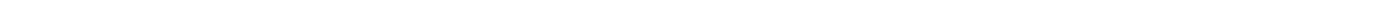
Figure 3 | Gene-deletion mutants Pb D mahrp1a and Pb D sbp1 show reduced schizont sequestration and virulence. ( a ) Survival of C57B/6 mice infected with mutant and wt parasites ( n ¼ 9 mice per group, P o 0.001, logrank test from Kaplan–Meier survival curve). ( b ) The course of parasitemia (mean ± s.d.) in C57B/6 mice ( n ¼ 15 mice per group) infected with 10 5 mutant or wt parasites. Significant differences in parasitemia between wt and both mutants at day 3, 6, 7 ( P o 0.001) and day 5 ( P ¼ 0.005) (two-tailed unpaired t -test). ( c ) Significant increase in number of mutant schizonts in the peripheral blood circulation compared with wt. Schizonts were quantified in Giemsa-stained smears of tail blood obtained 22h after establishing synchronised infections (ratio of the number of mutant to wt schizonts, n ¼ 12 mice per group, P ¼ 0.01; two-tailed unpaired t -test). ( d ) Representative distribution of sequestered schizonts in mice with synchronised infections 22h post infection of mutant and wt parasites that express luciferase as shown by measuring luciferase activity (photons per s per cm 2 ; shown as radiance, y ; n ¼ 15 mice per group). ( e ) Quantification of parasite loads in isolated organs after perfusion 22h after synchronised infections with mutant and wt parasites expressing luciferase. Parasite loads were determined by measuring luciferase activity (photons tissues from UBC-GFP mice 22h after establishing synchronized infections of mutant and wt parasites that express mCherry. Insets in the images of fat tissue are enlargements of the yellow boxes. Arrowheads indicate parasites. Size bars, 10 m m. ( g ) Spleens of mutant-infected mice are significantly larger (spleen-to-body weight ratio) than spleens of wt-infected mice ( n ¼ 9 mice per group, * P o 0.0001; unpaired Student’s t- test; infections were done